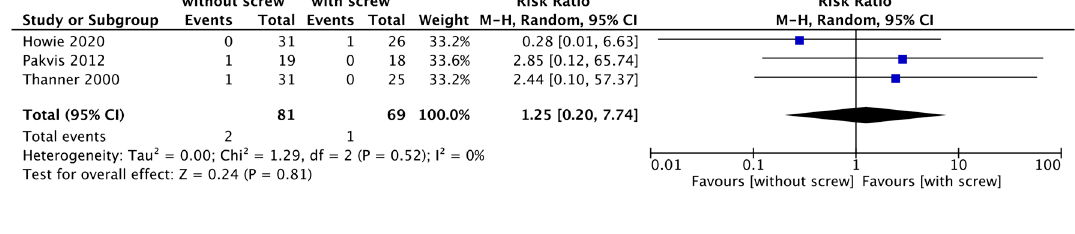
Mantel-Haenszel test, df: degrees of freedom).